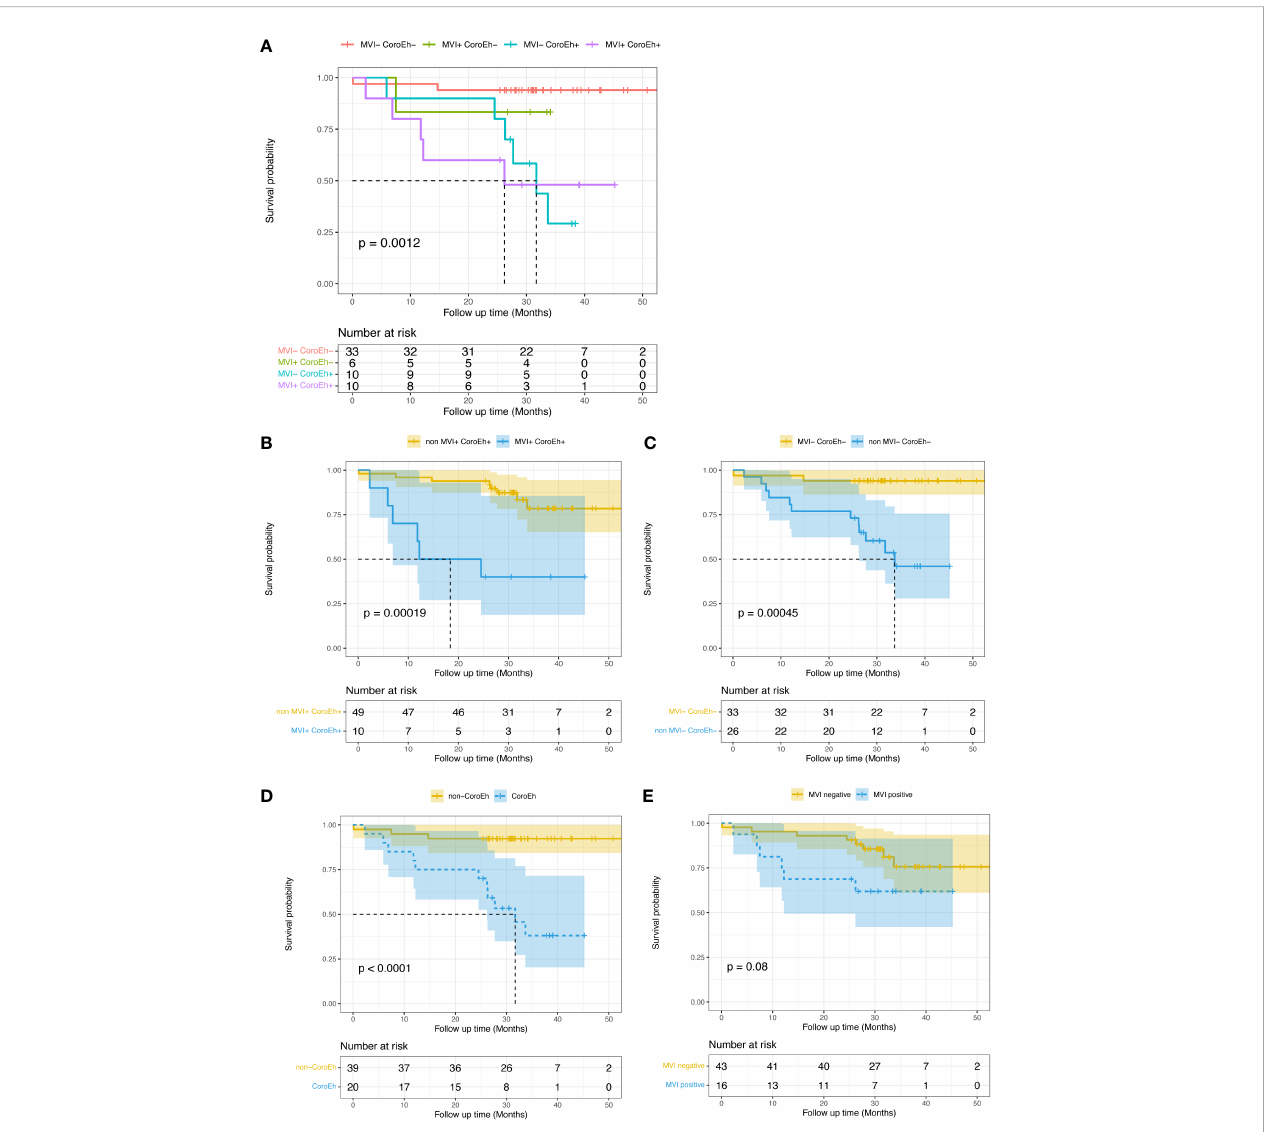
FIGURE 5 Kaplan-Meier plots show the impacts of macrovascular invasion (MVI) risk and coronal enhancement status (CoroEh) on overall survival (OS) after surgery in the validation cohort. (A) OS is compared among four validation subgroups: patients without MVI or CoroEh (MVI − CoroEh − ) and patients with one or both markers (MVI + CoroEh − , MVI − CoroEh + , and MVI + CoroEh + ). OS was signi fi cantly associated with the (B) non-MVI + CoroEh + (p<0.001) and (C) MVI − CoroEh − ( P <0.001) subgroups. OS was also signi fi cantly associated with (D) CoroEh status ( P <0.0001); however, (E) MVI was not signi fi cantly associated with OS. P -values were based on the log-rank